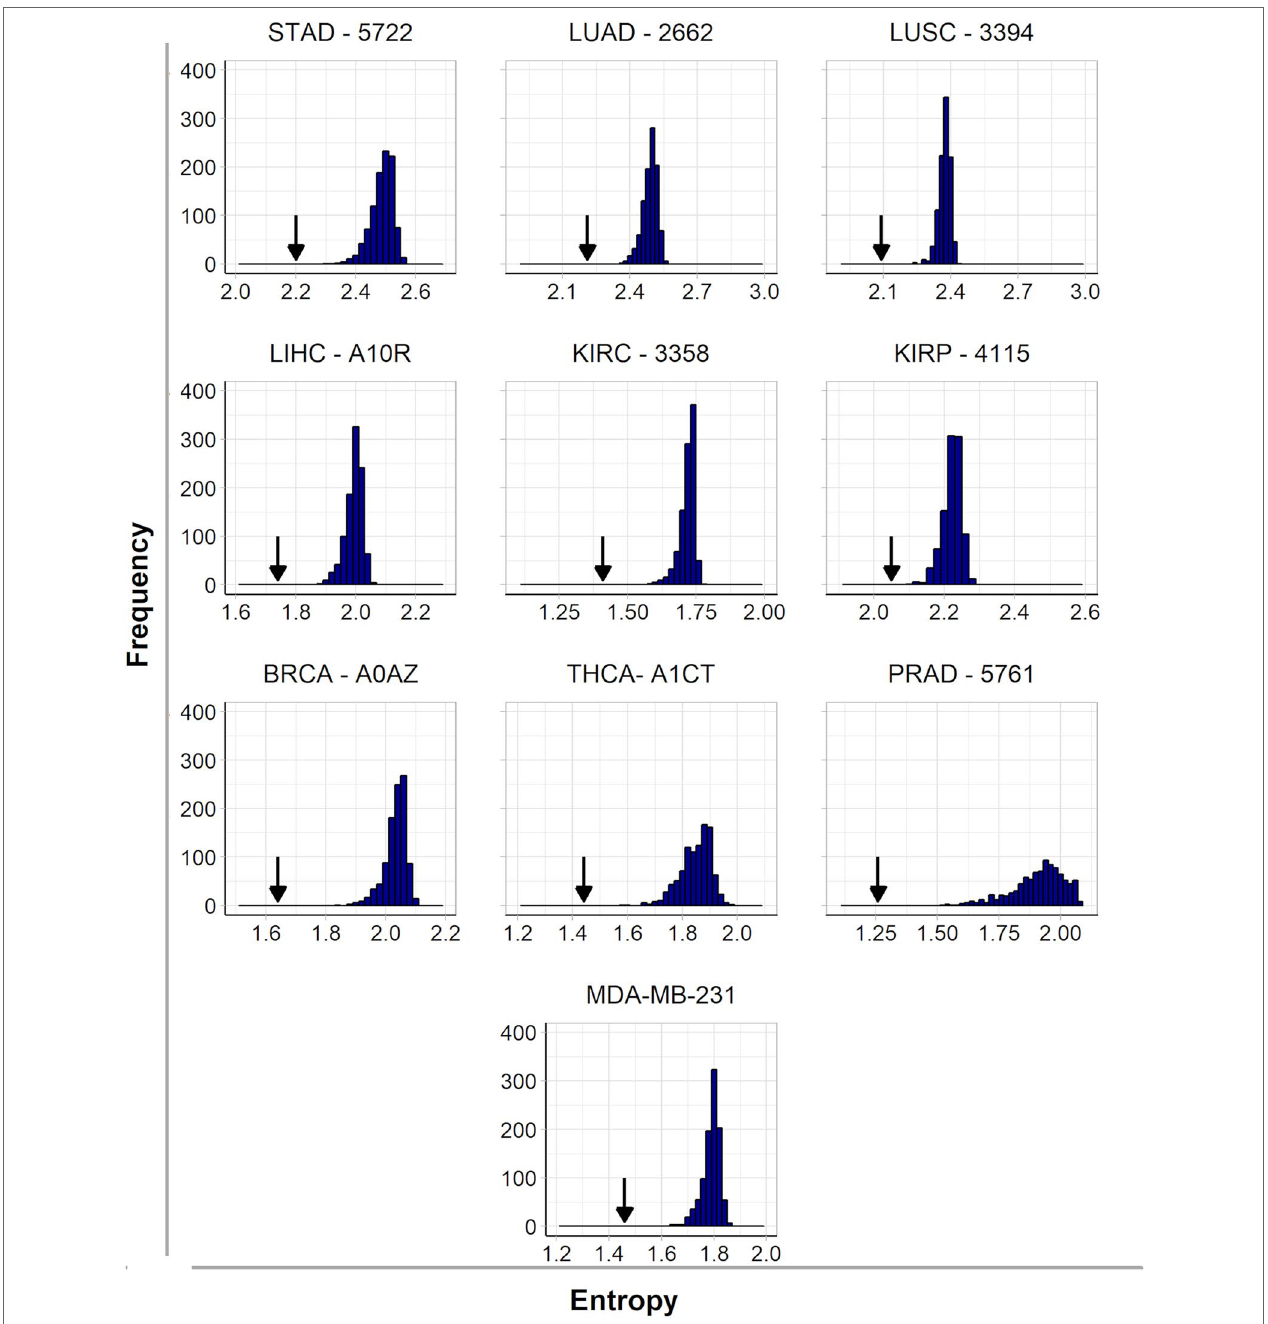
FIGURE 1 | Histograms of frequency and entropy distribution after inactivation of targets selected at random from subnetworks of up-regulated genes from nine patients (one from each cancer type) and the cell line MDA-MB-231. The arrows indicate the entropy found after hubs’ inactivation from the same